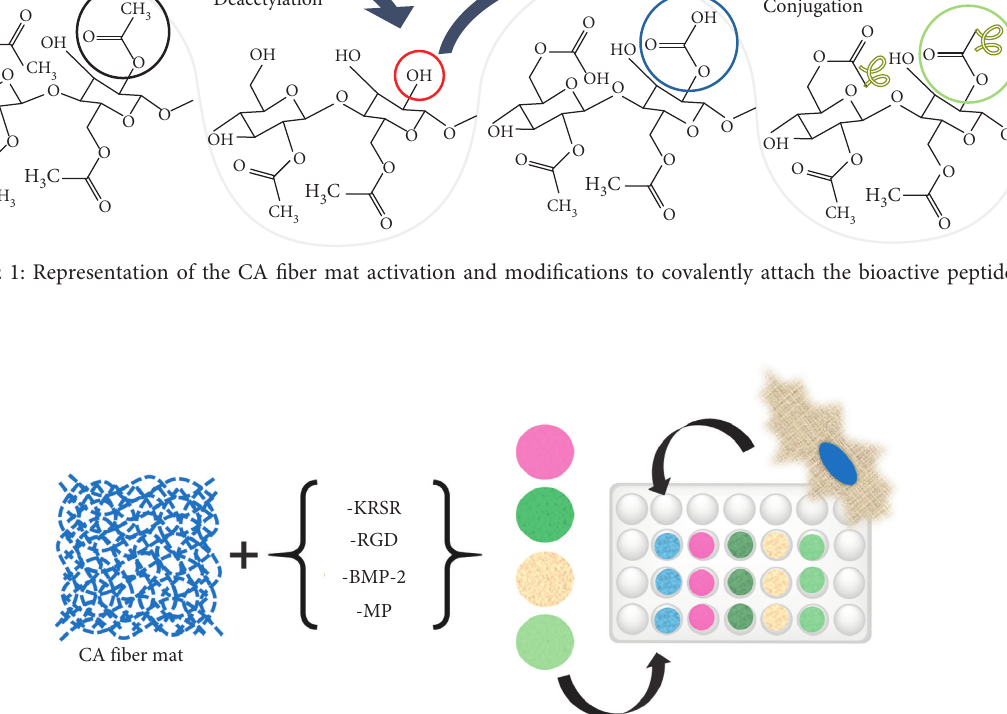
Scheme 2: Experimental well plate design for immunocytochemical